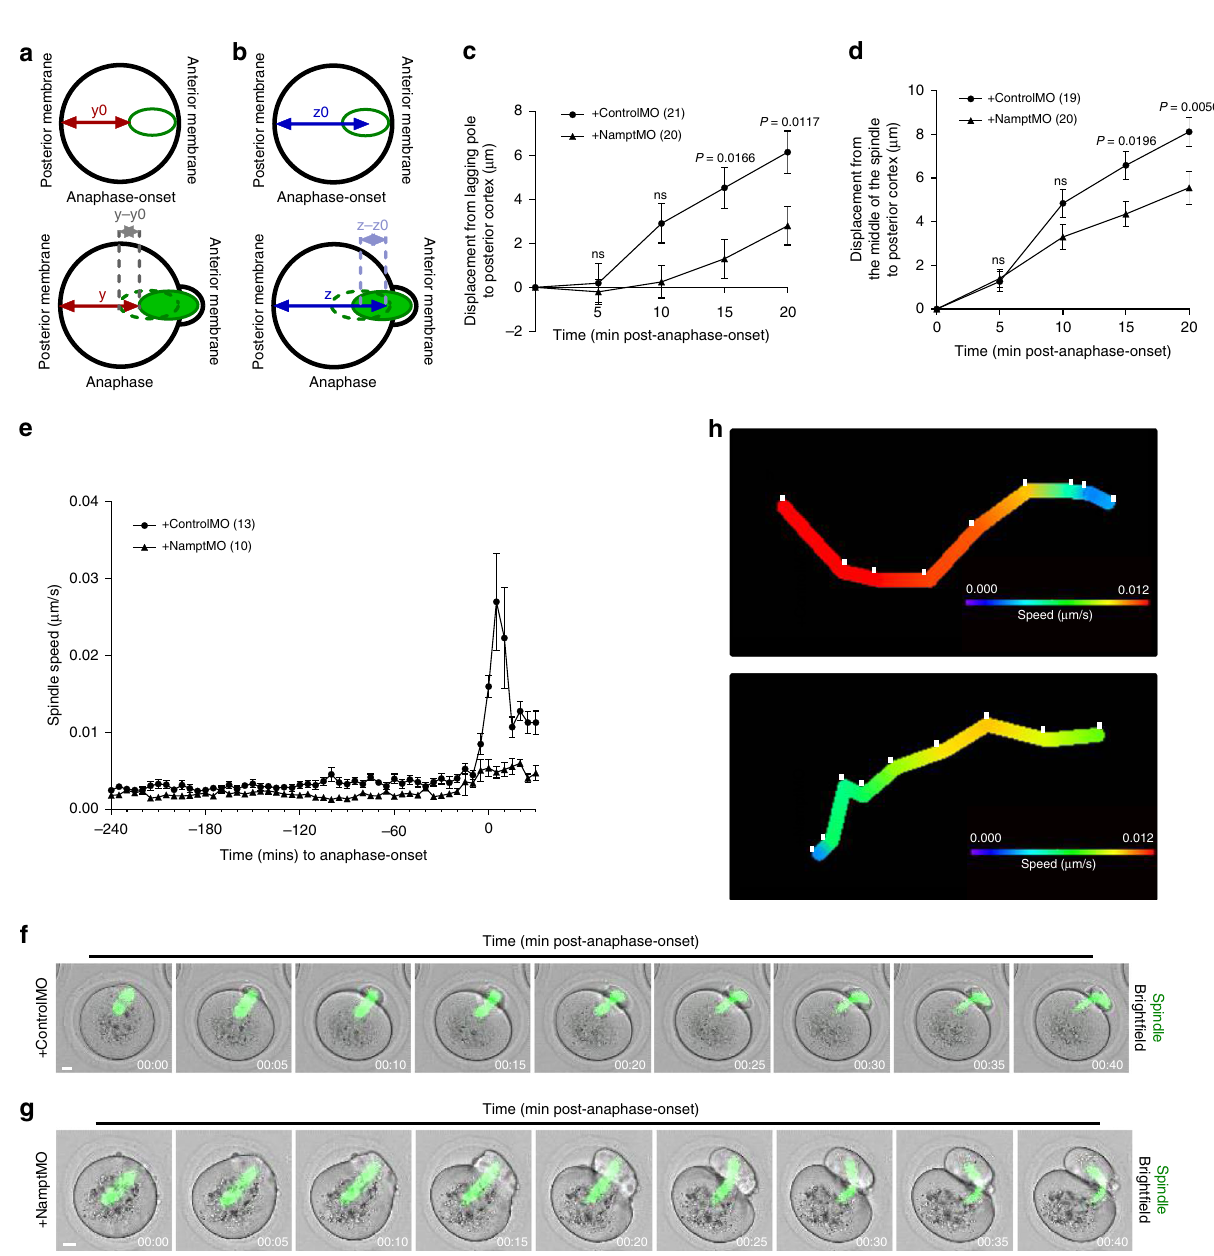
Fig. 4 Post-anaphase-onset spindle acceleration. a , b Schematics depicting the spindle displacement measurements plotted in c and d . c , d Posterior pole displacement ( y − y 0 ( a )) ( c ) and midzone displacement (z − z 0 ; ( b )) ( d ) during anaphase. e Mean spindle migration speeds relative to anaphase-onset for mock-depleted and Nampt-depleted oocytes. Note the increase in speed in mock-depleted oocytes that is absent after Nampt-depletion. f , g Shown are panels comprise selected bright fi eld and fl uorescence frames from representative time-lapse series of mock-depleted ( f ) and Nampt-depleted ( g ) oocytes. Time, h:min relative to anaphase-onset. Scale bars, 10 µ m. Representative images from three independent experiments are shown. h Tracks of spindle migration speeds during anaphase for the oocytes shown in f and g . White marks correspond to the position of the spindle at each consecutive time point shown in f and g . Note that in the mock-depleted oocyte shown, spindle speed is maximal (red track) between anaphase-onset and 10-min post-anaphase- onset. Note that the distance between white tick marks does not correspond to the distance moved by spindles as this track is a 2D representation of motion that occurred in three dimensions. Oocyte numbers are shown in parenthesis from three independent experiments ( c – e ). Data in graphs are presented as the mean ± SEM. P -values are shown in the graphs, ns denoted P > 0.05. Statistical comparisons were made using two-way repeated measures ANOVA in c and d . See also Supplementary Movies 4 and 5. Source data are provided as a Source Data fi